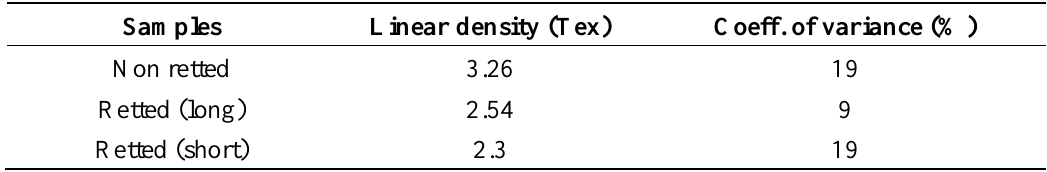
Table 2. Linear density of flax fibers.